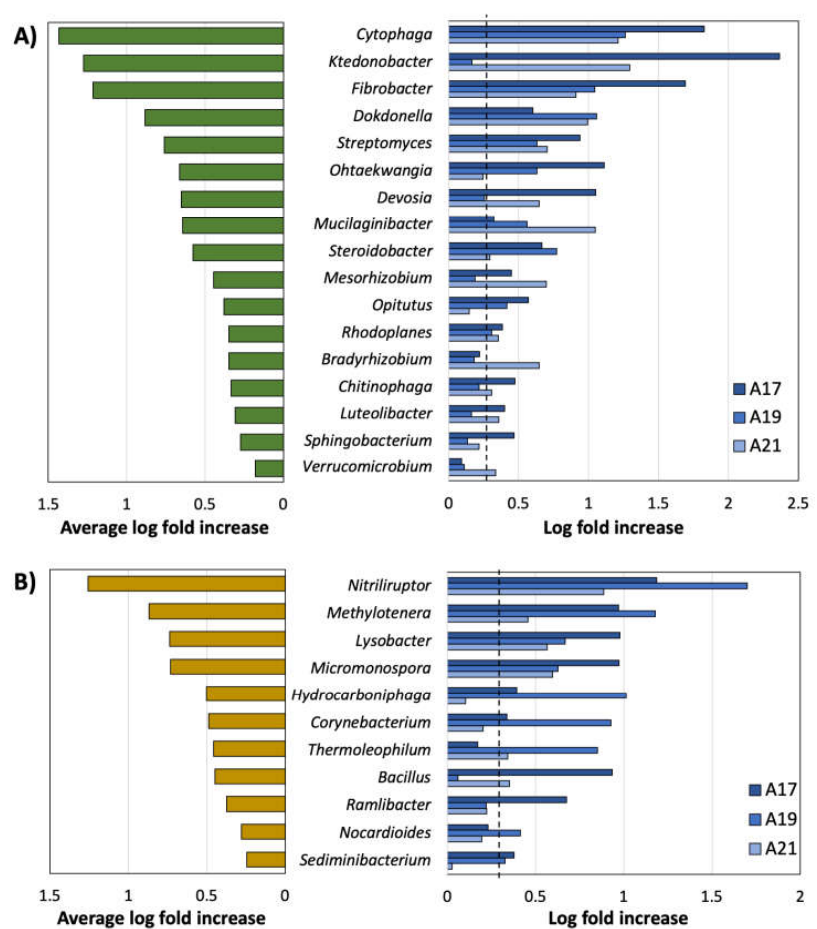
Figure 5. Genera with the largest average fold changes in invasive C. kobomugi stands ( A ) and barren microhabitats ( B ) when compared to each other. Left panel represents average log fold increases across all sites, while the right panel represents log fold increase for sites A17, A19 and A21. A log fold increase of 0.301 (2-fold increase) is shown in a segmented line for reference.